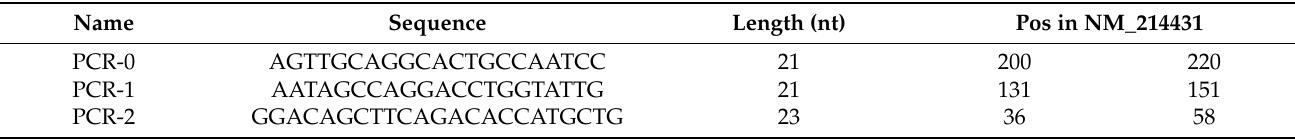
Table 2. Gene-specific reverse primers used for 5 ´